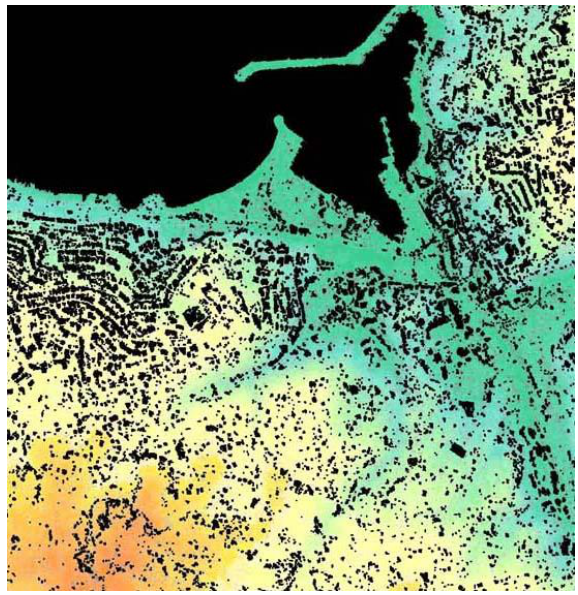
Figure 13. Result of filtering (black: filtered objects and Black Sea, colour = terrain height)